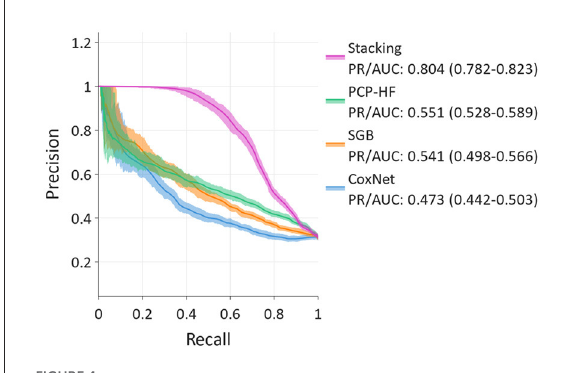
FIGURE4 Precision-recall curves for 10-year prediction showing stacking, Survival Gradient Boosting (SGB), CoxNet, and PCP-HF. Stacking exhibits the best discrimination.